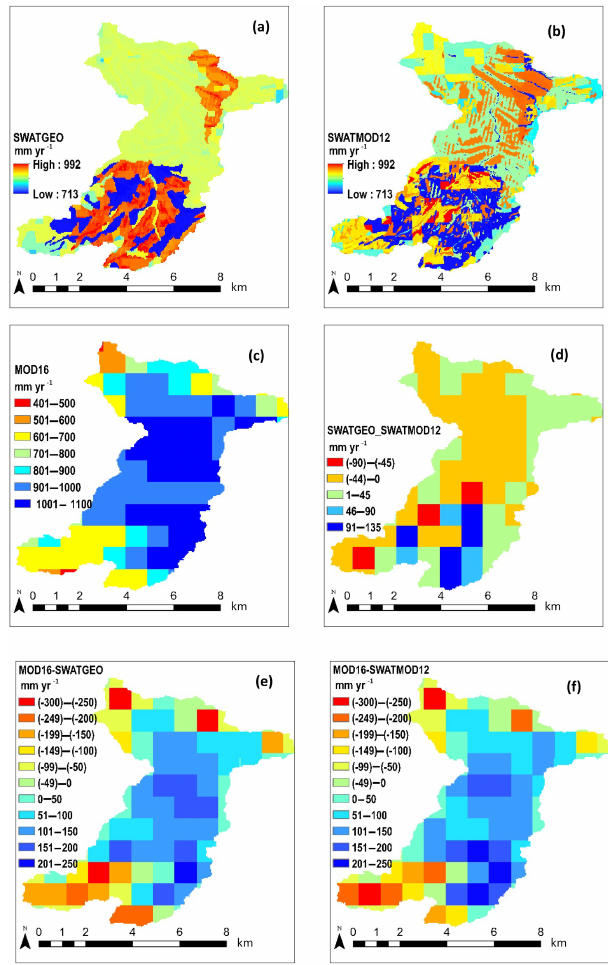
Figure 7. (a) HRU-scale SWATGEO mean ET (2007–2013); (b) HRU-scale SWATMOD12 mean ET (2007–2013; (c) 1km 2 grid MOD16 mean ET (2007–2013); (d) mean difference between SWATGEO and SWATMOD12 for corresponding 1km 2 grid cells (2007–2013); (e) mean difference between MOD16 and SWATGEO for corresponding 1km 2 grid cells (2007–2013); (f) mean differ- ence between MOD16 and SWATMOD12 for corresponding 1km 2 grid cells (2007–2013).